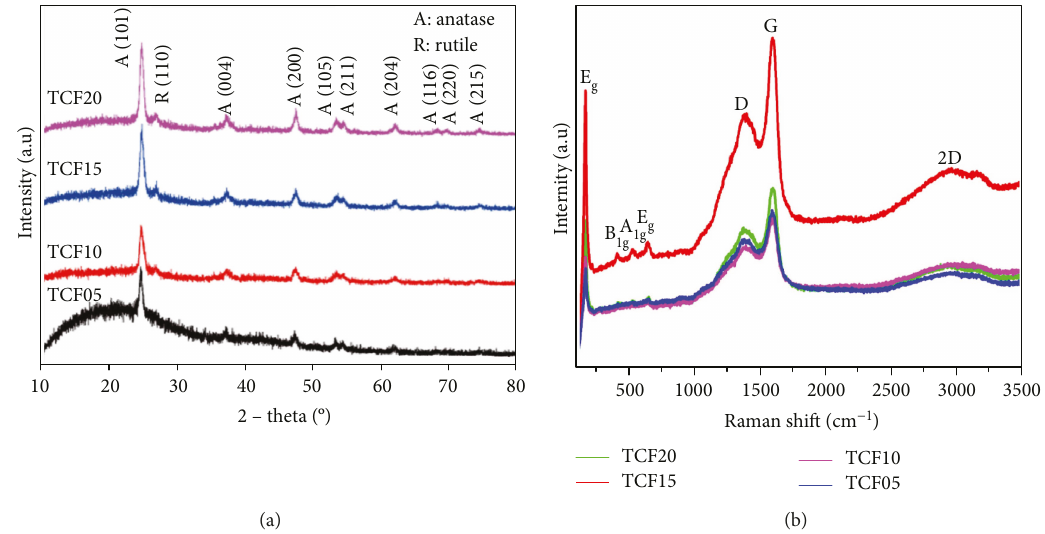
Figure 2: XRD patterns (a) and Raman spectra (b) of TiO